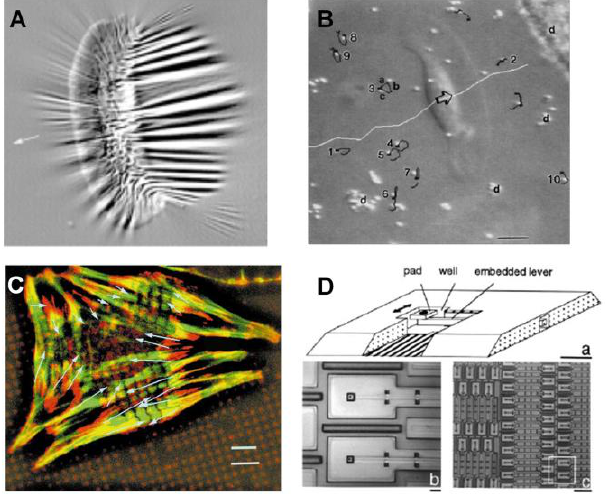
Figure 3. Four examples of sensing techniques for measuring CTFs. A. Thin silicone membrane. Note that a large number of wrinkles are created on the membrane by CTFs of a single cell (reproduced with permission from Figure 1 in [12]). B. Micro-beads-embedded elastic membrane (reproduced with permission from Figure 7 in [37]). C. Micropatterned silicone membrane with an array of fluorescent micro-dots (reproduced with permission from Figure 4 in [4]). D. Microfabricated cantilever array (adapted with permission from Figure 1 in